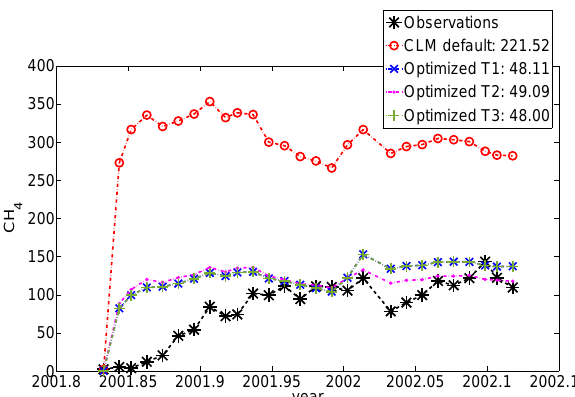
Figure 6. CH 4 emission observations and predictions when using the optimized parameters of optimization trials T1, T2, and T3, re- spectively, and when using the default parameters for the rice paddy site Central Java, Indonesia, for the real data case with d = 5 param- eters. The legend shows the lowest RMSE value found in each trial.